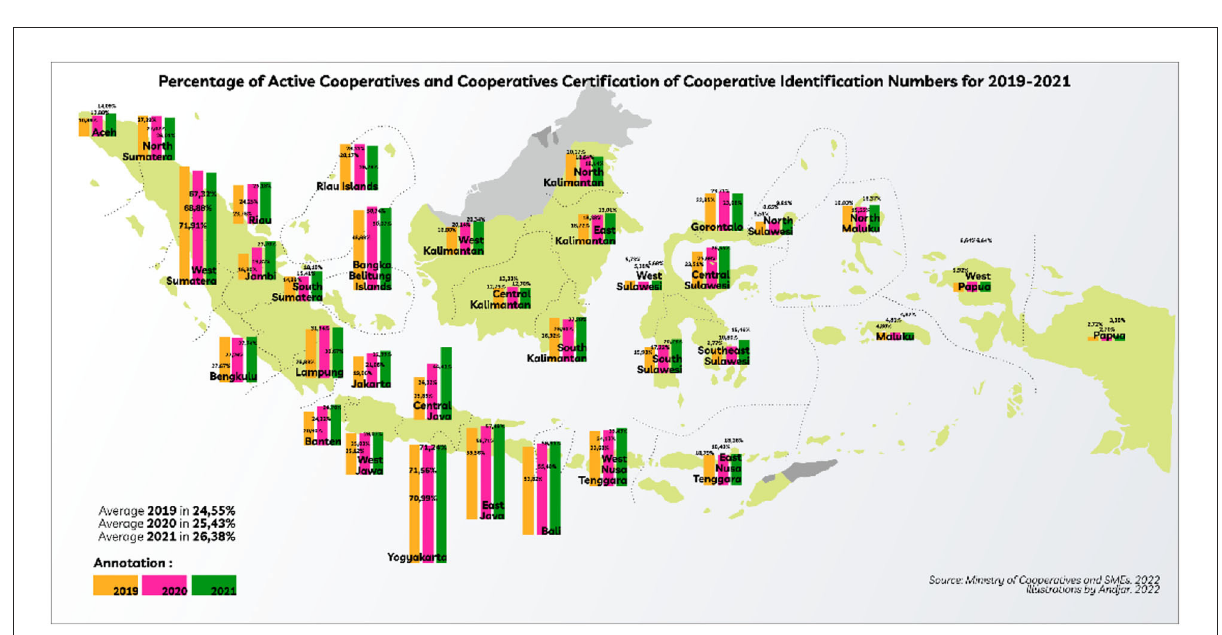
FIGURE2 Percentage of active cooperatives and cooperatives certification of cooperative identification numbers for 2019–2021.